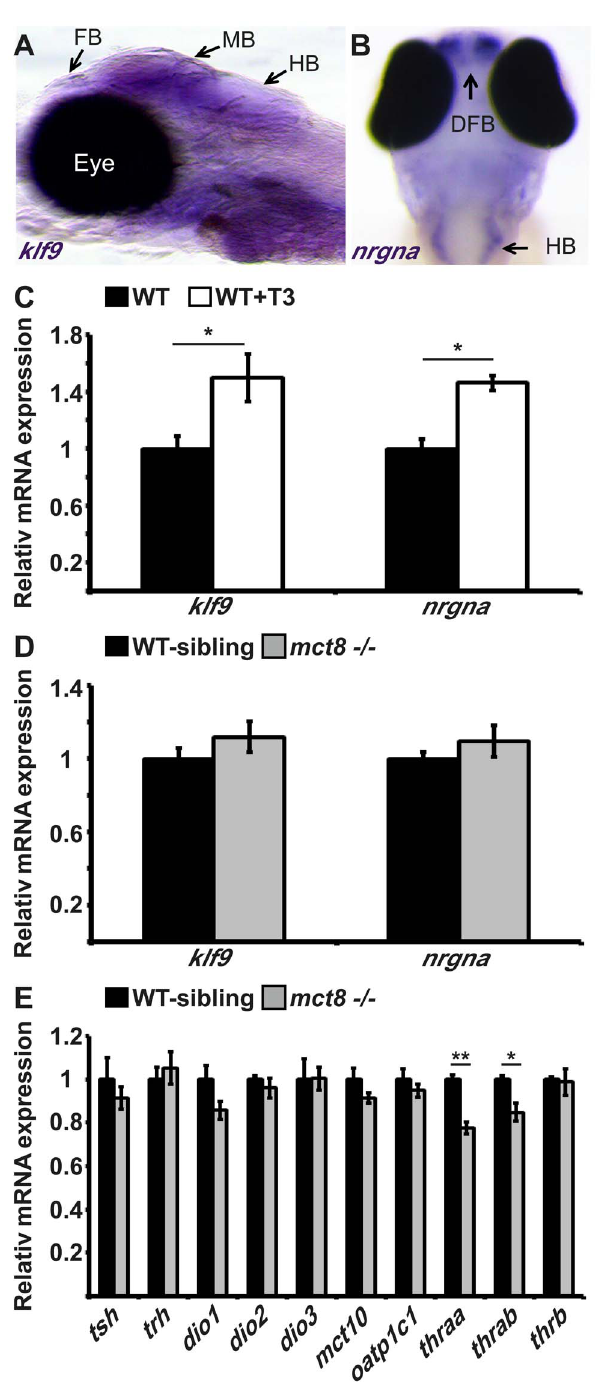
Figure 2. The expression of TH-induced and HPT-axis genes in mct8 2 / 2 embryos. A . The expression pattern of klf9 in the forebrain (FB), midbrain (MB), and hindbrain (HB) of 6 dpf larvae (lateral view), as detected by whole-mount ISH. B . nrgna is predominantly expressed in the dorsal forebrain (DFB) and HB in 3 dpf embryo (dorsal view), as detected by whole-mount ISH. C . Relative mRNA expression levels of klf9 and nrgna in untreated and T3-treated WT embryos. D . Relative mRNA expression of klf9 and nrgna in 3 dpf mct8 2 / 2 and their WT- sibling embryos. E . Relative mRNA expression levels of tsh , trh , dio1 , dio2 , dio3 , mct10 , oatp1c1 , thraa , thrab and thrb in 3 dpf mct8 2 / 2 and their WT-sibling embryos. Values represented as means 6 SEM (standard error of the mean). Statistical significance determined by t -test: